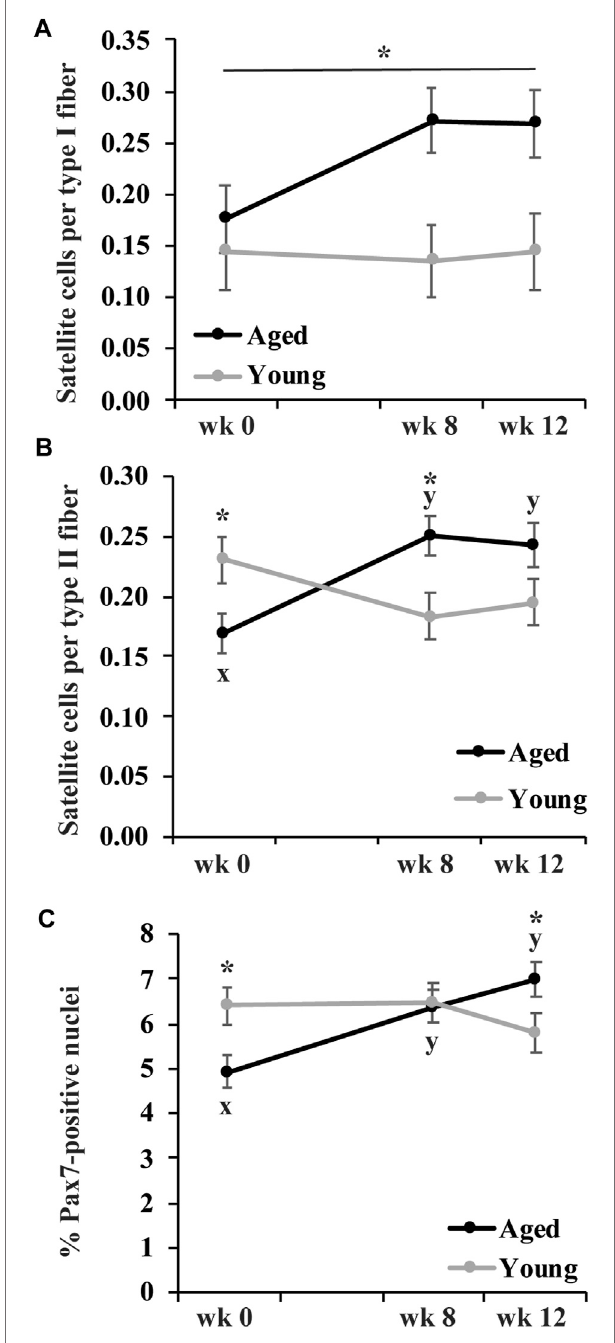
FIGURE 3 | Gluteus medius and triceps brachii satellite cells per type I fi ber (A) ,satellitecellspertypeII fi ber (B), andpercentofPax7-positivenuclei (C) before (wk 0),and after 8(wk 8) and 12 (wk 12) weeksofsubmaximalexercise trainingin aged(22 ± 4.5yr; n (cid:1) 10) and young(9.7 ± 0.7mo; n (cid:1) 8)horses.Owingto lack ofeffectofmuscle group,musclegroups havebeen combined. Overall effect ofage( p (cid:1) 0.0009; p (cid:1) 0.3; p (cid:1) 0.8),training( p (cid:1) 0.3; p (cid:1) 0.4; p (cid:1) 0.056),muscle group( p (cid:1) 0.1; p (cid:1) 0.6; p (cid:1) 0.8),age × training( p (cid:1) 0.2; p (cid:1) 0.0007; p (cid:1) 0.003),age × musclegroup ( p (cid:1) 0.9; p (cid:1) 0.9; p (cid:1) 0.6), training × muscle group ( p (cid:1) 0.96; p (cid:1) 0.6; p (cid:1) 0.4), and age × training × muscle group ( p (cid:1) 0.14; p (cid:1) 0.6; p (cid:1) 0.5) for satellite cells per type I fi ber, satellite cells per type II fi ber, and percent of Pax7- positivenuclei,respectively.*Withintimepoint,ageddiffersfromyoung( p < 0.05). x,y Within aged horses, time points with different letters differ ( p < 0.05).